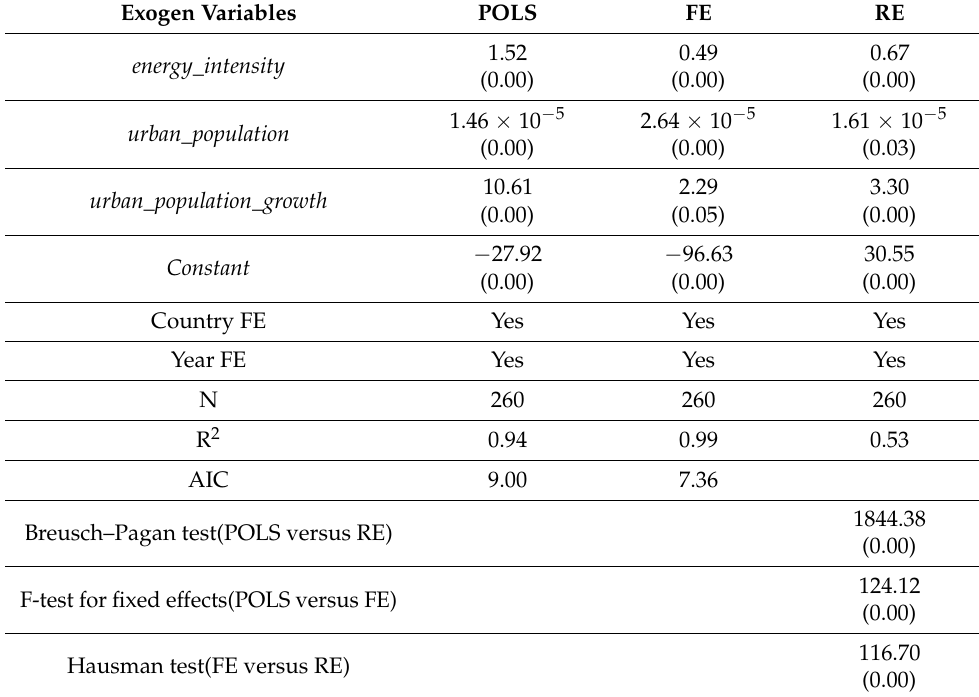
Table 5. Estimation of parameters for the model.